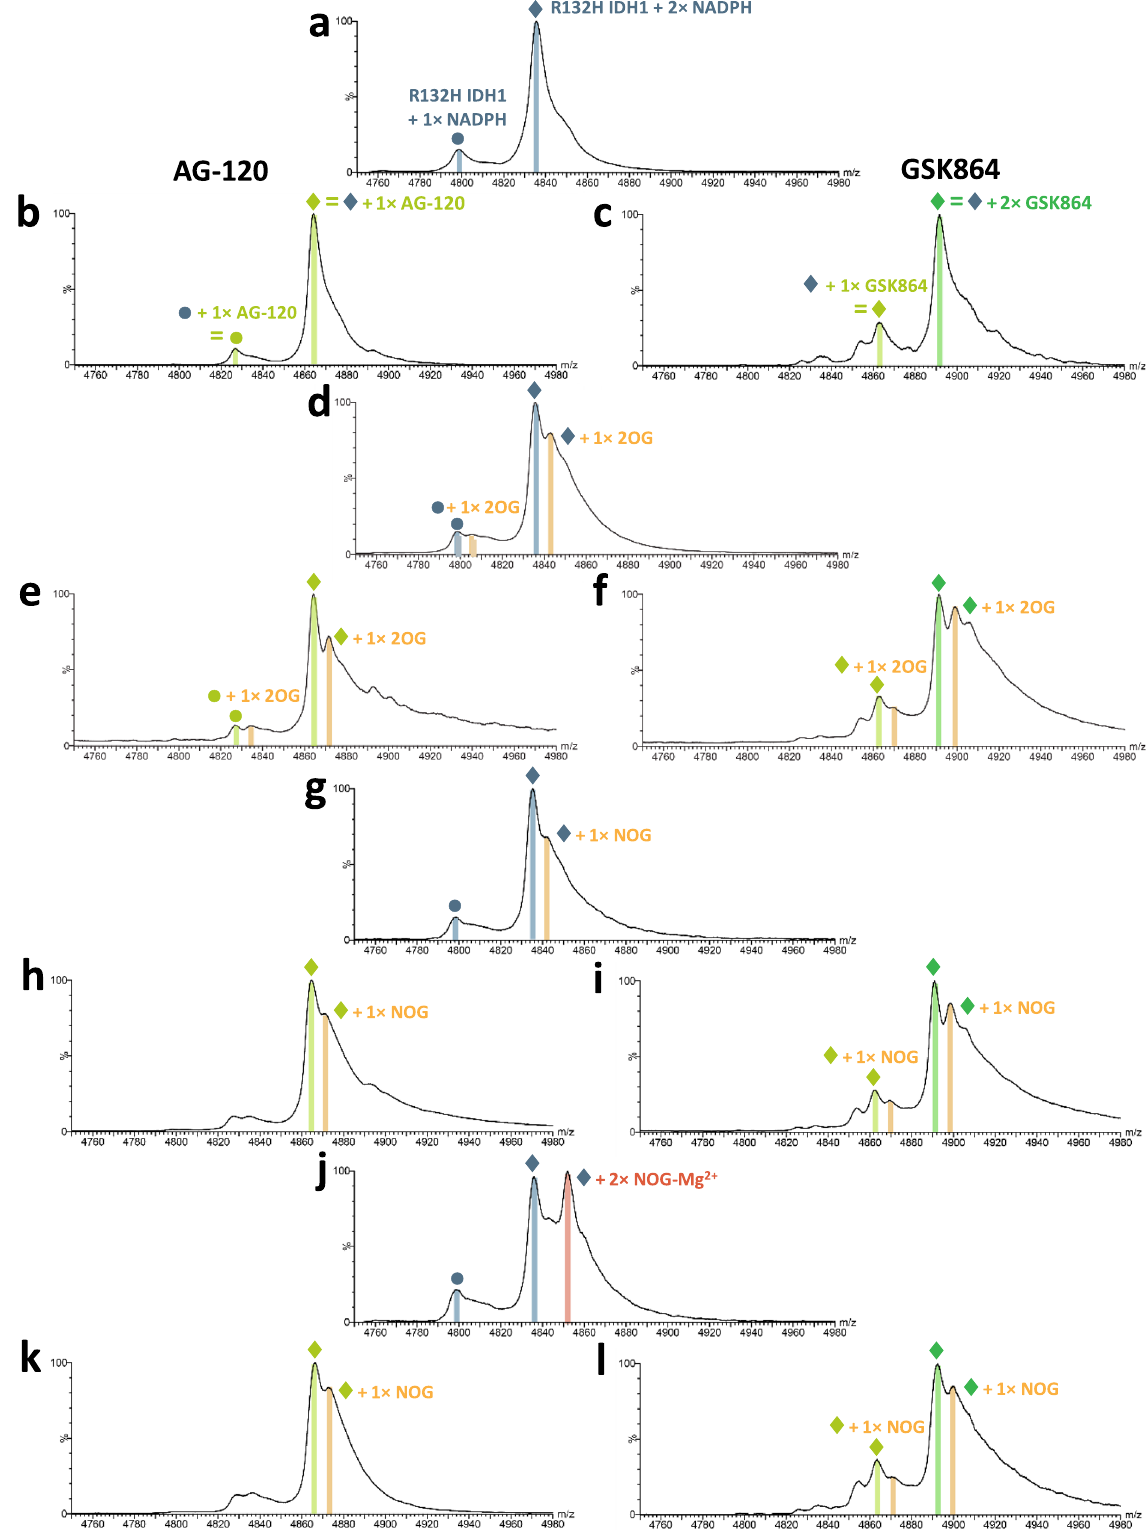
AG-120 or GSK864 does not affect 2OG/NOG binding, con- sistent with the binding of 2OG and the inhibitors at non- overlapping sites (Fig. 4e, f, h, i). In the presence of MgCl 2 , two NOG molecules were observed to bind to each R132H IDH1 dimer, supporting the proposal that Mg 2 + ions enhance NOG (and by implication 2OG) binding (Fig. 4j). In contrast to